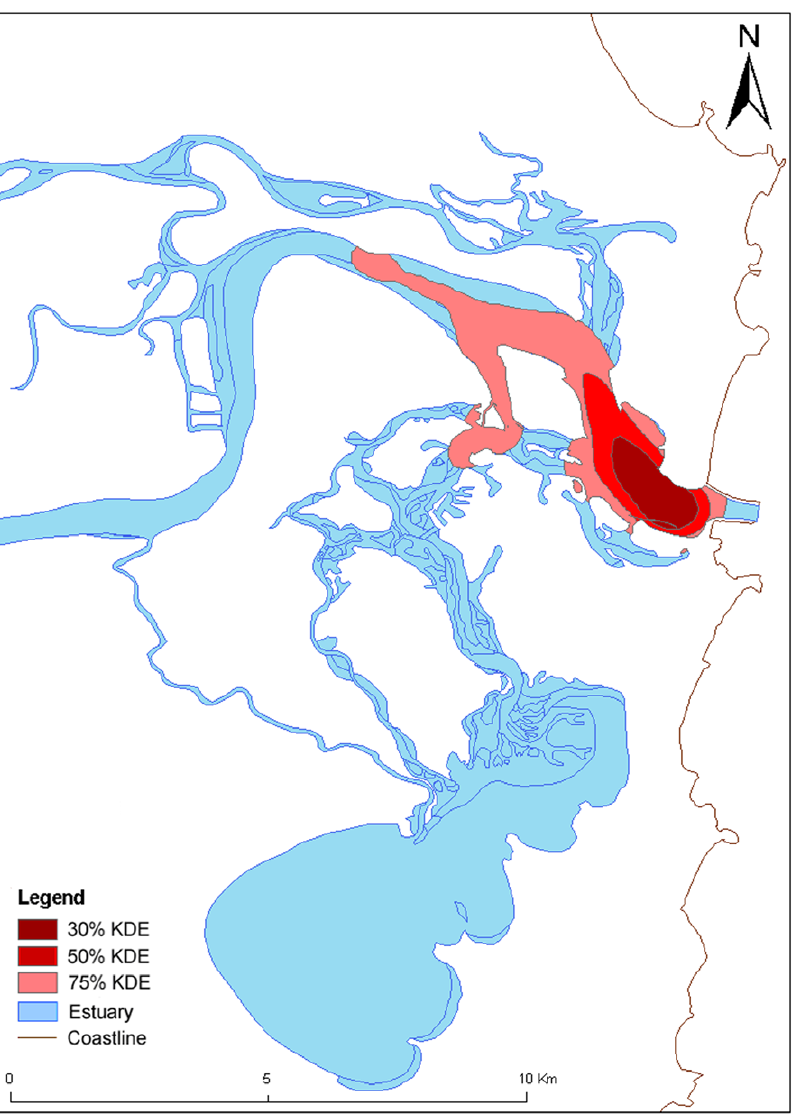
Figure 5. Mixed-sex groups’ kernel density estimates (KDE) for all behaviours from the Clarence River estuary (N=1118).